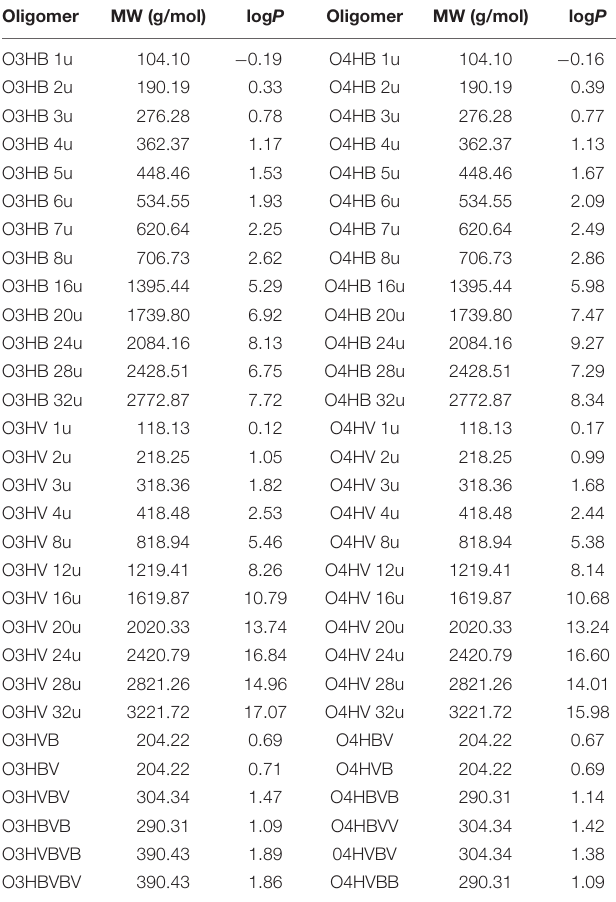
TABLE 3 | Molecular weight (MW) and lipophilicity (logP) of oligomers considered in this study.